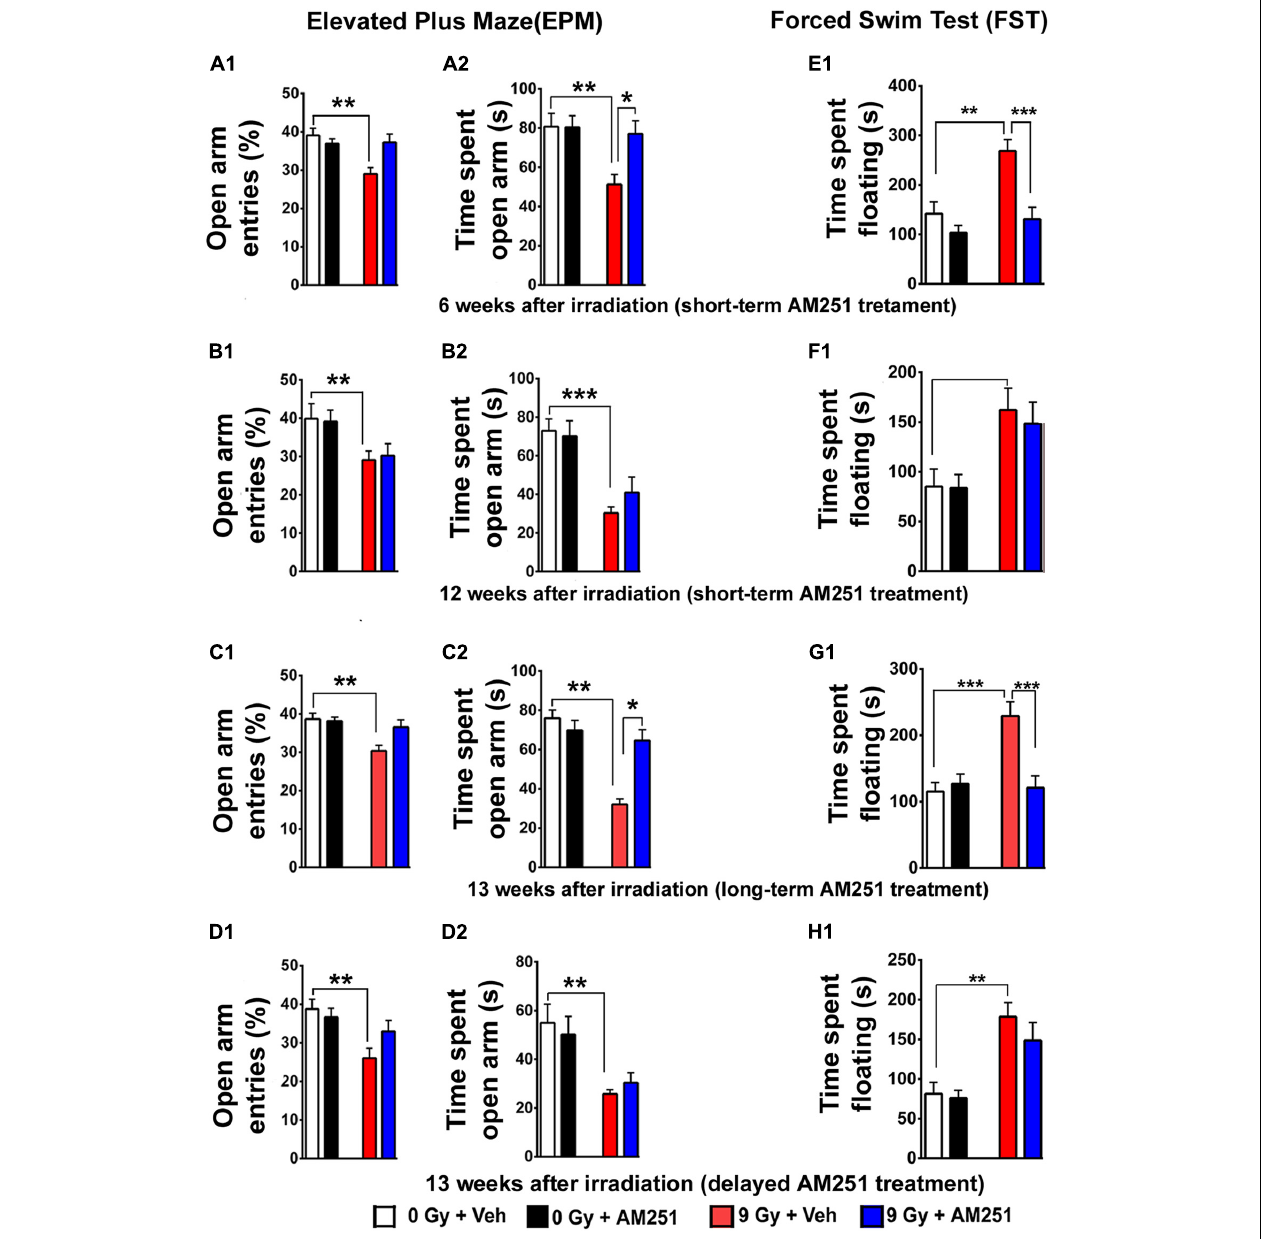
FIGURE 3 | AM251 ameliorates anxiety and depressive-like behavior in irradiated mice. EPM: Short-term AM251 treatment reduced anxiety-like-behavior in mice 6 weeks following irradiation evidenced by the significant increased time spent in open arms (A1,A2) . However, benefits derived from this same short-term treatment did not persist 12 weeks after irradiation (B1,B2) . At similar protracted postirradiation times, long-term AM251 treatments were found to significantly reduce anxiety-like behavior (C1,C2) . Delayed AM251 treatment was not effective at resolving radiation-induced anxiety-like behavior 13 weeks after irradiation (D1,D2) . FST: Short-term AM251 treatment reduced significantly depressive-like behavior in irradiated mice at 6 weeks after irradiation (E1) but not at 12 weeks postirradiation (F1) . Long-term treatments with AM251 improved were found to reduce depressive-like behavior 13 weeks following irradiation (G1) but not when a single treatment was delayed (H1) . Data presented as means ± SEM, N = 8–12. P -values derived from two-way ANOVA followed by Bonferroni correction for multiple comparisons. * P < 0.05; ** P < 0.01; and *** P <